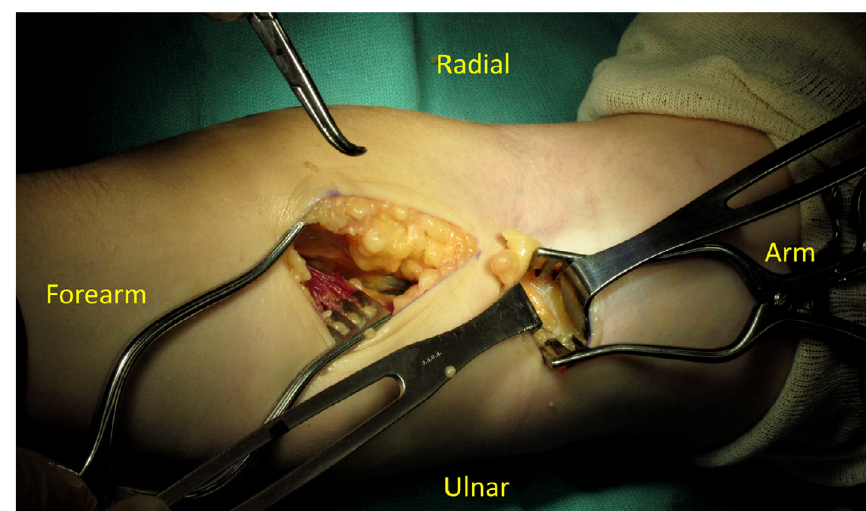
Figure 2. Pronator release by two separated incisions (during